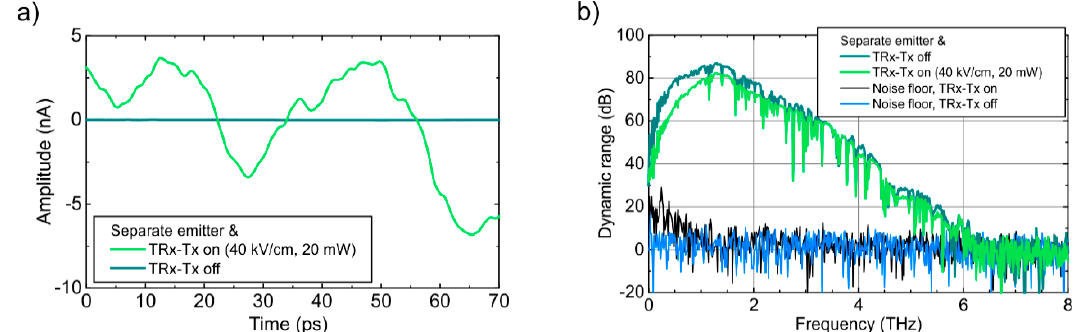
Figure 5. Influence of the emitter part of a THz transceiver on the detected THz signal emitted by a separate THz emitter. ( a ) The detected time-domain signals when the THz path is blocked and ( b ) the THz power spectra for a deactivated emitter part (dark green) vs. an activated emitter part at 40 kV/cm bias and 20 mW optical power (light green). The corresponding noise levels are shown in blue and black, respectively.